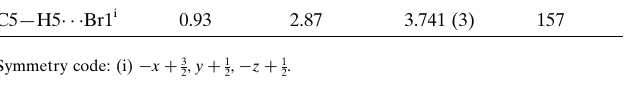
Table 2 Experimental details. Crystal data Chemical formula